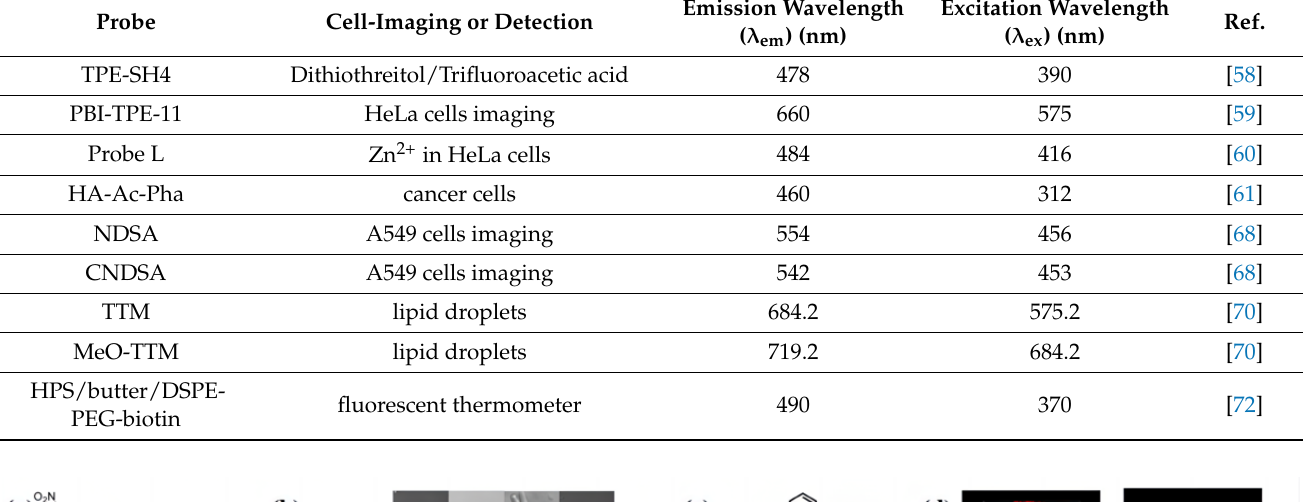
Table 1. The important parameters of the AIE material design strategy based on the functional groups.